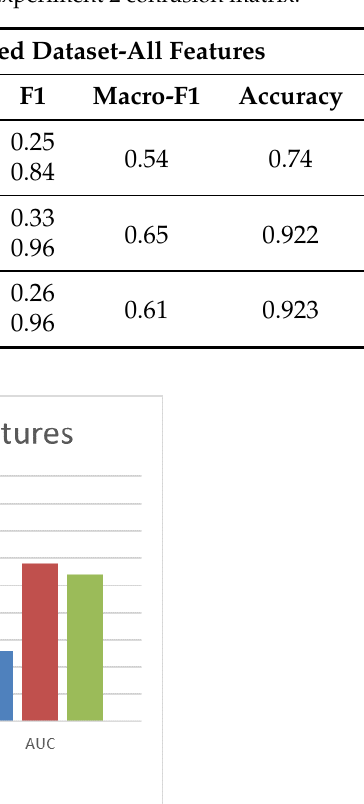
Table 4. Non-augmented dataset with all features—Experiment 2 confusion matrix.